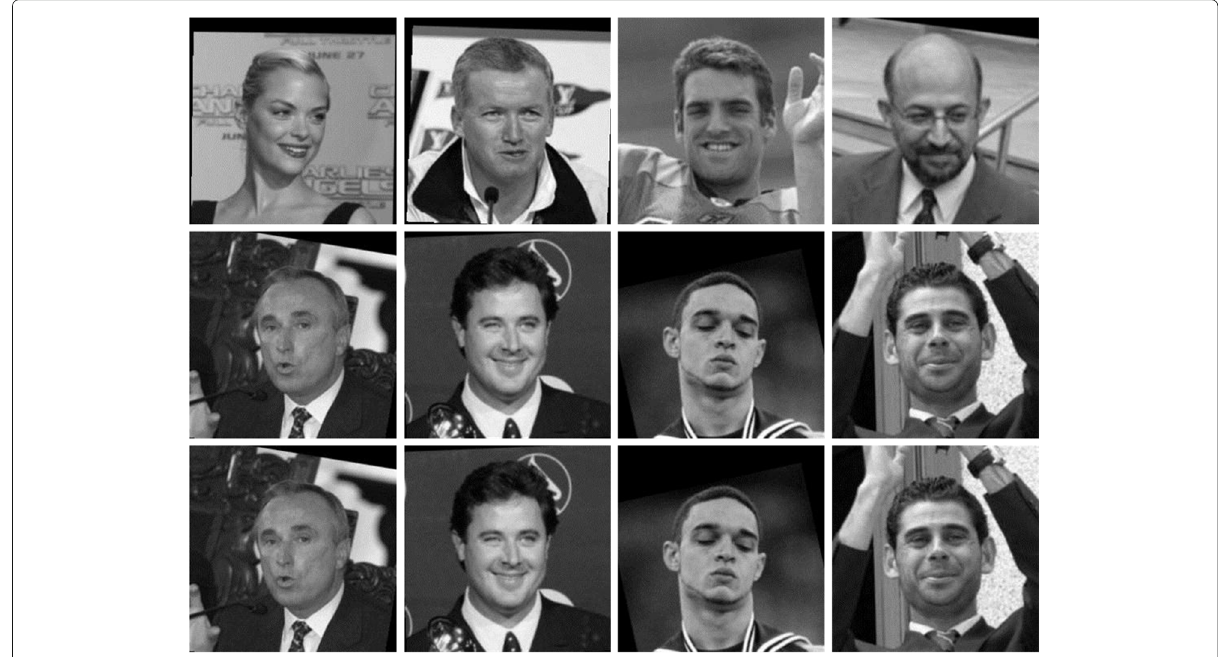
Fig. 6 Experimental results after the model is